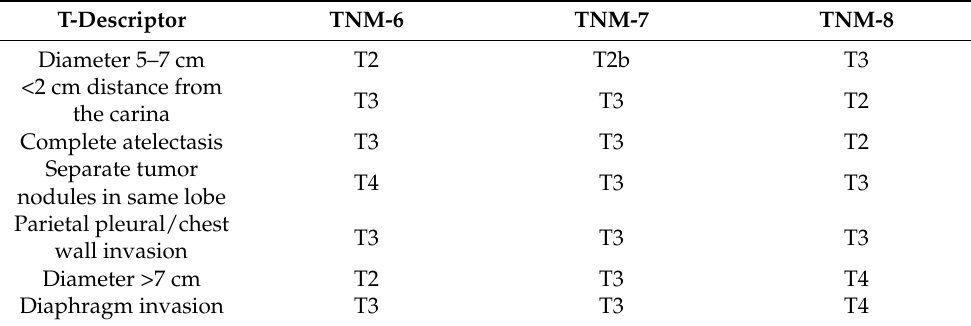
Table 1. Changes in NSCLC T3 descriptors between 6th, 7th, and 8th